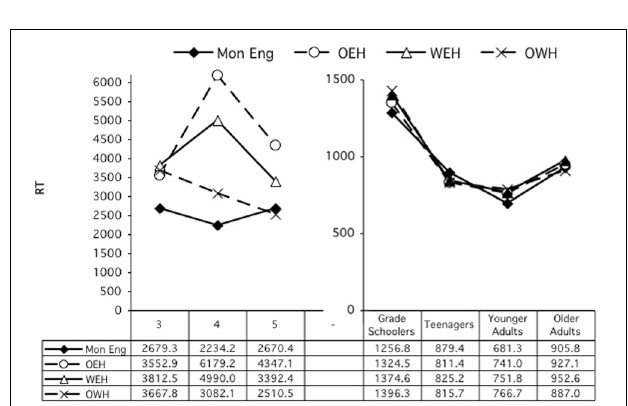
FIGURE 4 | Simon task: accuracy by age and home language, incongruent condition.